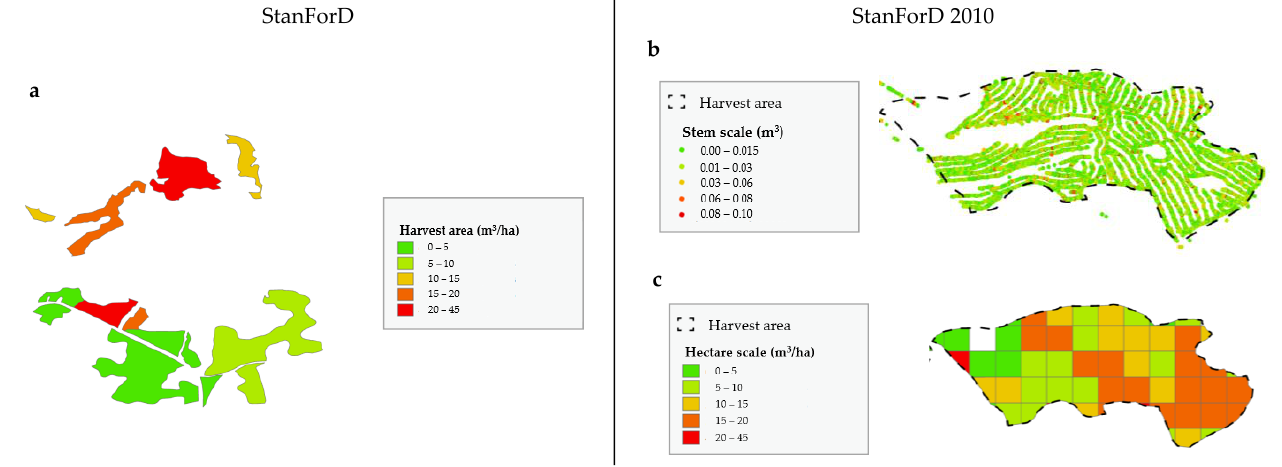
Figure 9. Graphical display of the outputs obtained from the NUWM spatialization tool; for StanForD ( a ) at a harvest area scale and StandForD 2010 ( b ) at a stem scale, ( c ) at a hectare scale (100 × 100 m grid).